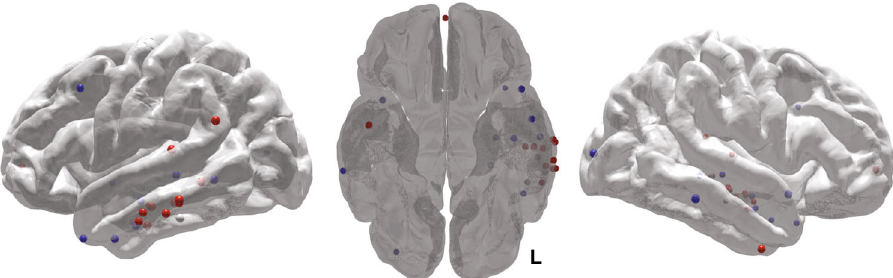
Fig. 4 Stimulation targets rendered on an average brain surface. Targets showing numerical increase/decrease in free recall performance are shown in red/ blue. Memory-enhancing sites clustered in the middle portion of the left middle temporal gyrus (coordinate range X : − 67 to − 47; Y : − 51 to − 1; Z : − 33 to